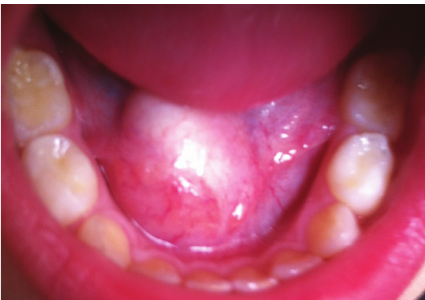
Figure 1: Preoperative photograph of the sublingual mass. An asymptomatic mass can be seen which protrudes discreetly onto the floor of the